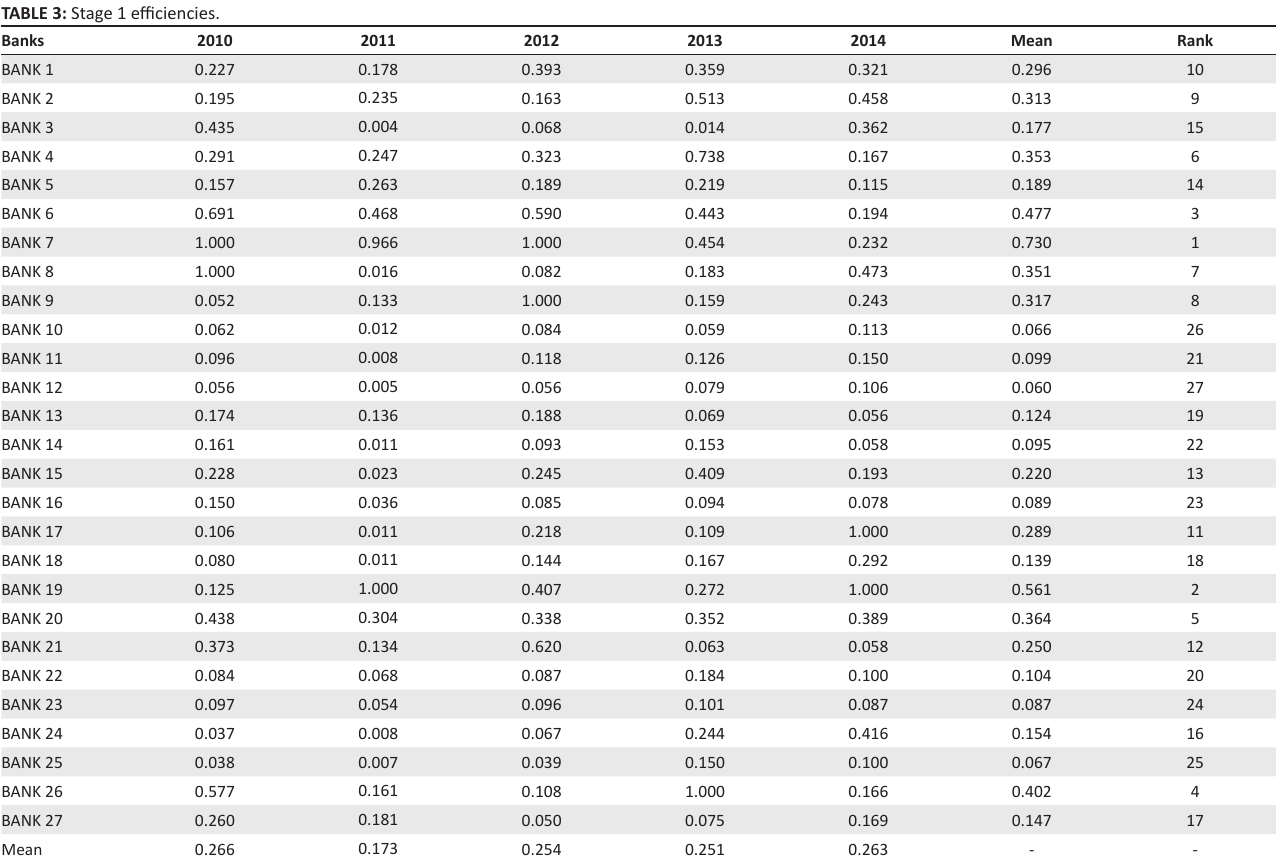
TABLE 3: Stage 1 efficiencies.